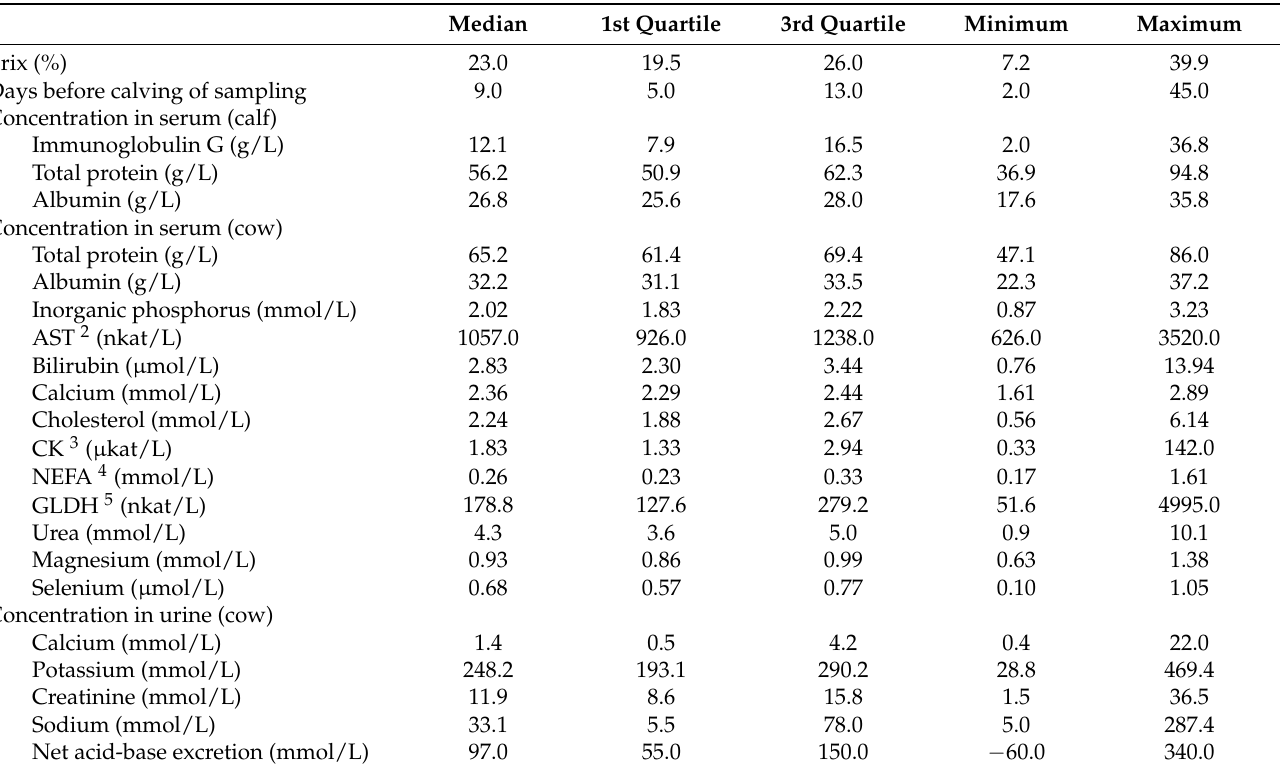
Table 2. Medians, quartiles, minimums and maximums of metabolic variables and Brix values of 511 German dairy cows and their calves 1